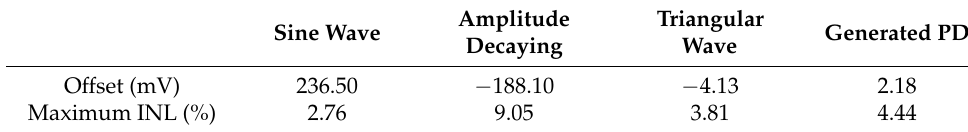
Figure 15. Experimental results showing variation of v PEAK with RMS input for various waveforms. Table 3. Model name of each block of the proposed system.